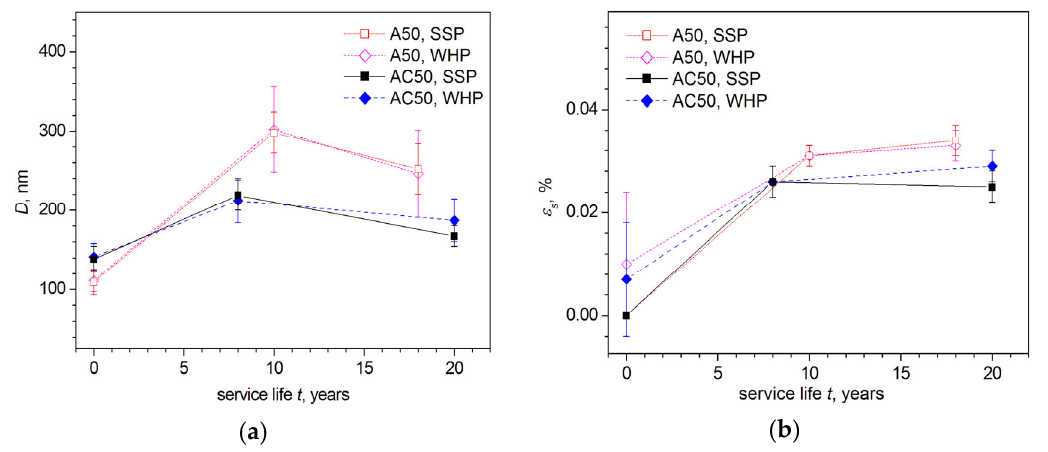
Figure 14. Comparison of dependences of ( a ) average crystallite size D and ( b ) absolute value of average microstrain ε s , calculated by the WHP and SSP techniques, on the service ‐ life duration t for Al wires from the cables of the AC50 and A50 types.